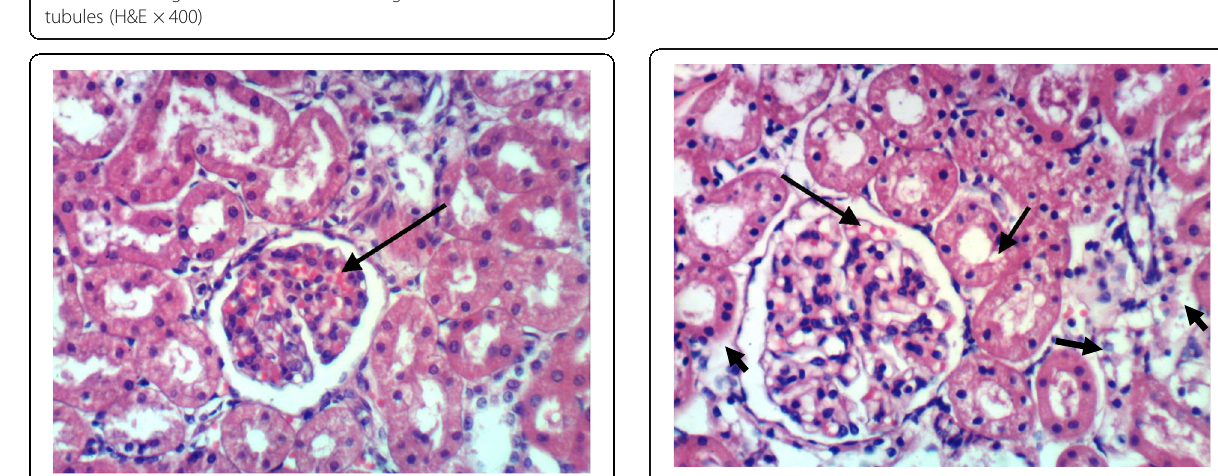
Fig. 11 Photomicrograph of rat ’ s kidney fed the balanced diet supplemented with vaniilin + oral pot.bromate, showing slight congestion of the glomerular tuft (H&E × 400)